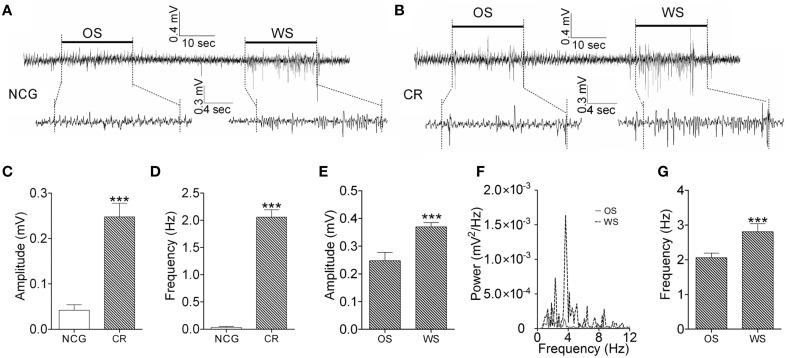
The activity patterns of barrel cortical neurons in response to OS and WS from CR-formation mice and controls. Neuronal activities were recorded by LFP in vivo. (A) Top trace shows that the neurons in the barrel cortex from a NCG mouse do not respond to OS (left horizontal bar), but respond to WS (right). Calibration bars for this trace are 0.4 mV and 10 s. Bottom traces illustarte the expanded waveforms from the fragments of no response to OS (left) and of response to WS (right). Calibration bars for these traces are 0.3 mV and 4 s. (B) Top trace shows that the neurons in the barrel cortex from a CR-formation mouse respond to OS (left horizontal bar) and WS (right). Calibration bars for this trace are 0.4 mV and 10 s. Bottom traces show the expanded waveforms from the fragments of responses to OS (left) and WS (right). LFP amplitude and frequency appear different. Calibration bars for these traces are 0.3 mV and 4 s. (C,D) Show LFP amplitudes (C) and frequencies (D) in response to OS, which are recorded in the barrel cortex from NCG mice (white bar; n = 9) and CR-formation mice (gray; p < 0.001, n = 9; One-Way ANOVA). (E) Shows LFP amplitudes recorded from the barrel cortex of CR-formation mice in response to WS and OS (p < 0.001, n = 9; One-Way ANOVA). (F) Illustrates the power-spectrum of LFP frequency in the barrel cortex of CR-formation mice in response to WS (dash line) and OS (solid line). (G) Shows LFP frequency recorded in the barrel cortex of CR-formation mice in response to WS and OS (p < 0.001, n = 9; One-Way ANOVA). ***p < 0.001.